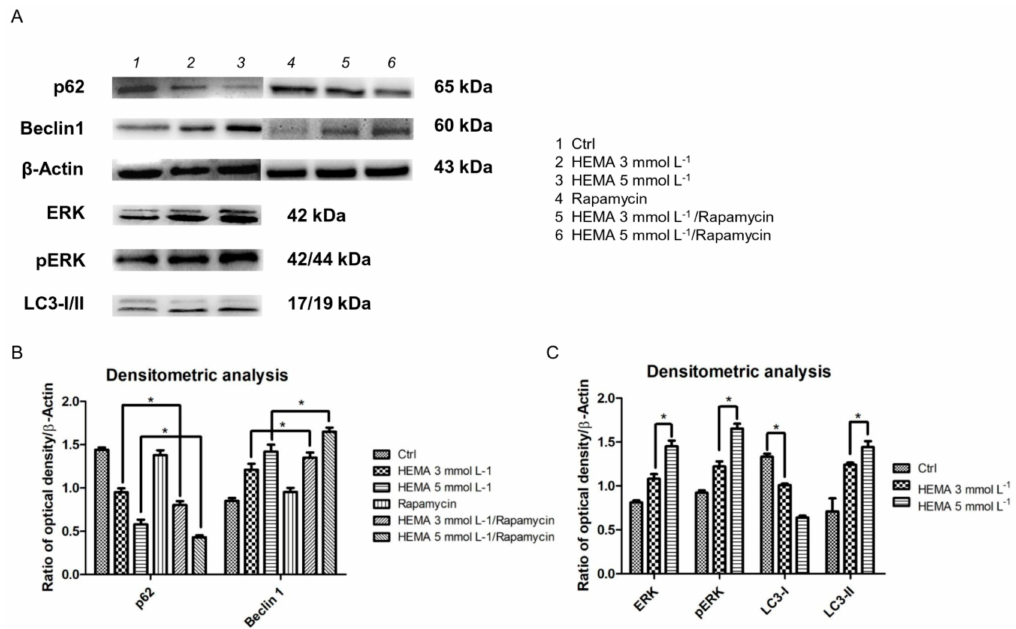
Figure 8. Western blot analyses. ( A ) Specific bands of p62, Beclin1, ERK, pERK, LC3-I / II, and β -Actin, used as housekeeping protein. ( B ) Densitometric analysis histograms of p62 and Beclin1 in all experimental groups untreated and treated with rapamycin. ( C ) Densitometric analysis histograms of ERK, pERK, and LC3-I / II in untreated hDPSCs and treated with HEMA 3 mmol L − 1 and HEMA 5 mmol L − 1 . * p <